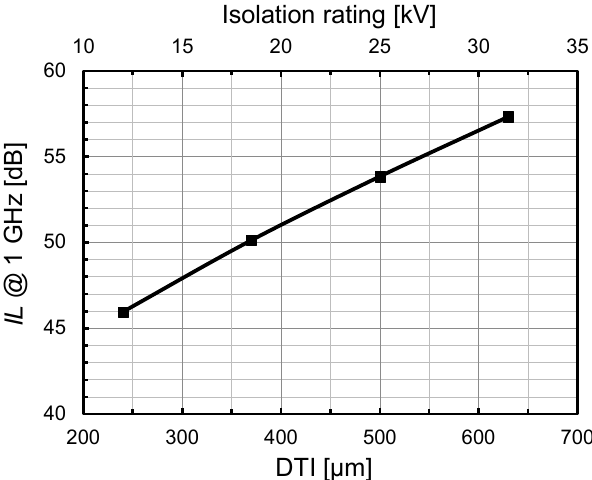
Figure 8. Antenna coupling IL at 1 GHz as a function of the DTI and corresponding galvanic isolation rating in the adopted 0.35-µm CMOS technology ( σ S = 10 S/m; E M = 50 V/µm).